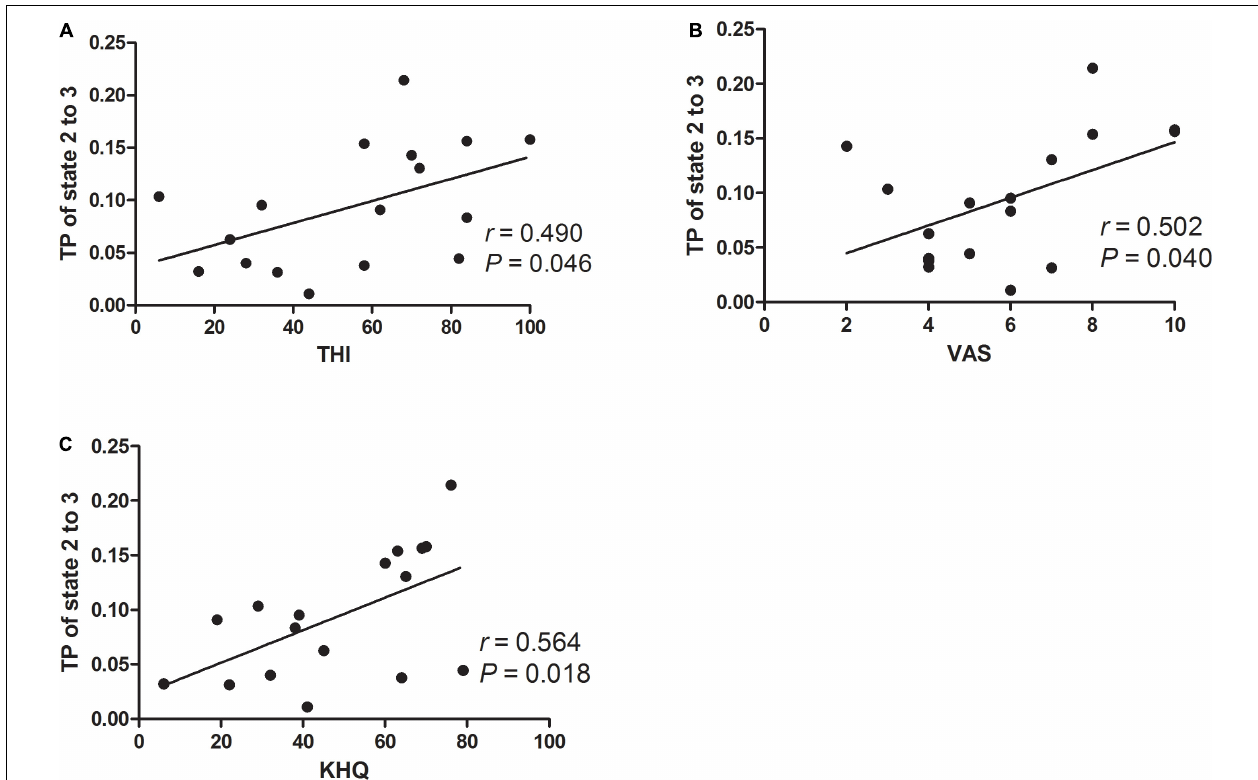
FIGURE 6 | Correlation between TP from state 2 to state 3 and tinnitus severity in chronic tinnitus patients before acupuncture. We found that the TP from state 2 to state 3 in chronic tinnitus patients before acupuncture positively correlated with THI (A) , VAS (B) , and KHQ (C) . KHQ, Khalfa hyperacusis questionnaire; THI, tinnitus handicap inventory; TP, transition probability; VAS, visual analog